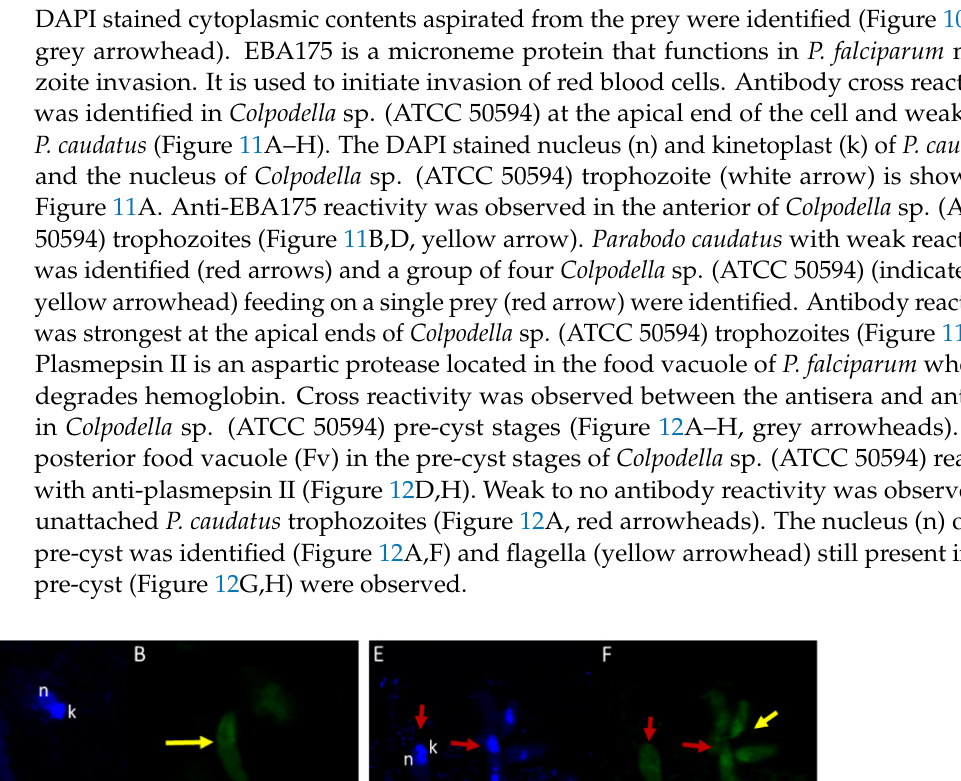
DAPI stained cytoplasmic contents aspirated from the prey were identified (Figure 10A,D, grey arrowhead). EBA175 is a microneme protein that functions in P. falciparum mero-